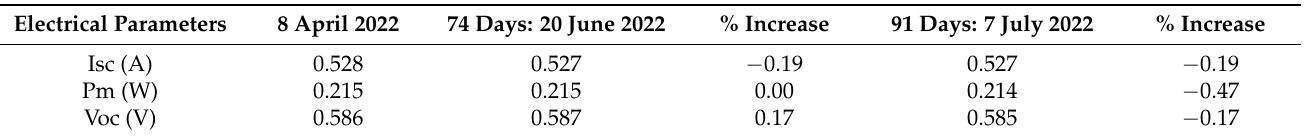
Table 6. Electrical parameters of encapsulated and PA Si-QDs coated Q2 sample from characterisation carried out 74 and 91 days apart.